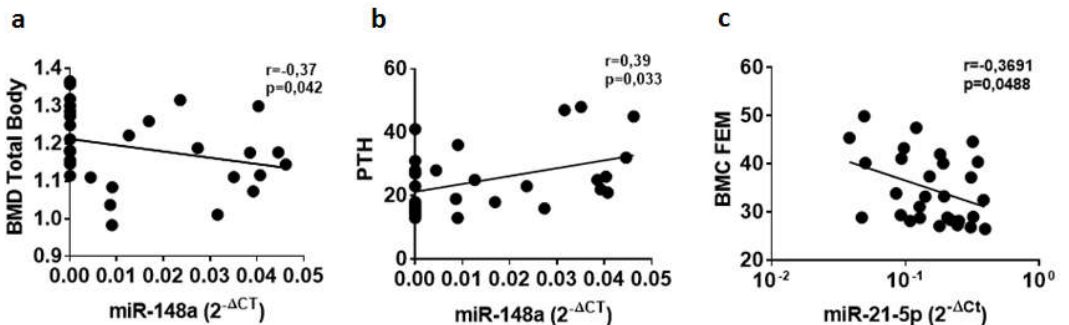
Figure 2. The expression of hsa-miR-148a and miR-21-5p levels are correlated with bone metabolism parameters in T1D patients and non-diabetic control subjects. Correlation analysis between miR-148a serum expression levels, reported as normalized 2 − ∆ CT values, and BMD total body (TB) reported as g/cm 2 ( a ) and circulating levels of parathormone (PTH) reported as pg/mL ( b ). Correlation analysis between miR-21-5p serum expression levels and BMC-FEM reported as g/cm 2 ( c ). Spearman R test was performed to evaluate r -values and p -values ( p < 0.05).